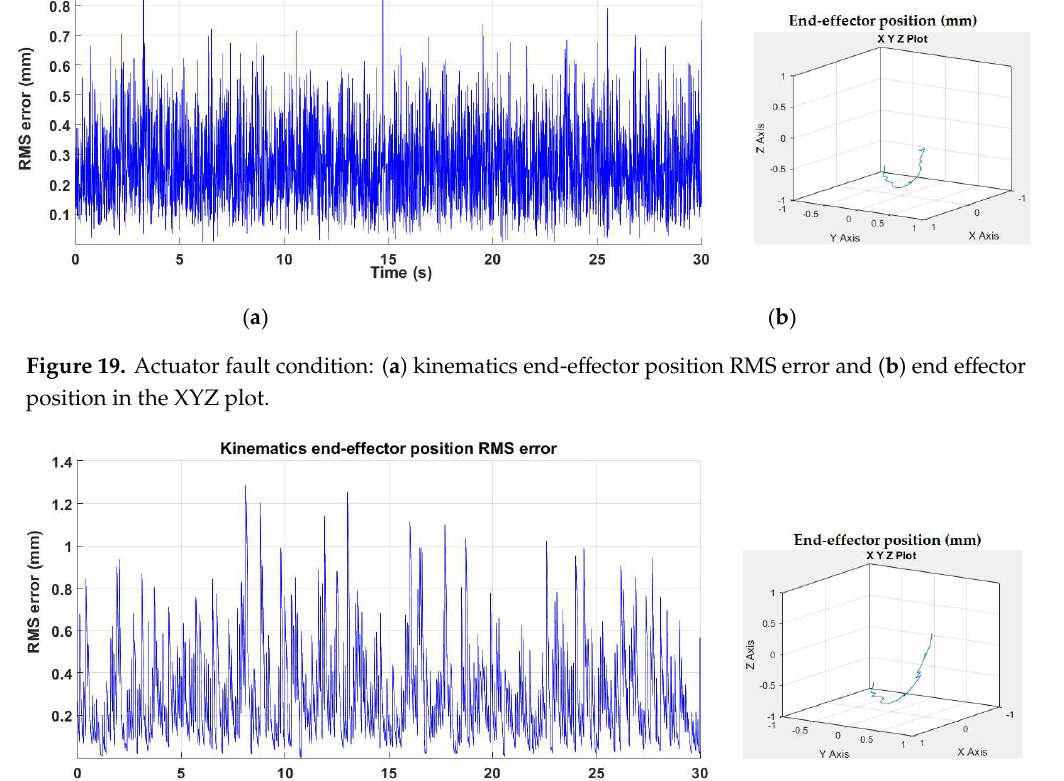
( b ) Figure 21. Actuator-sensor fault condition: ( a ) kinematics end-effector position RMS error and ( b ) end effector position in the XYZ plot. ( a ) ( b ) Figure 22. ( a ) Fault-tolerant control error and ( b ) error of position fault for the fuzzy feedback linearization method, observation-based feedback linearization method, and proposed method for the surgical robot for the sinus.